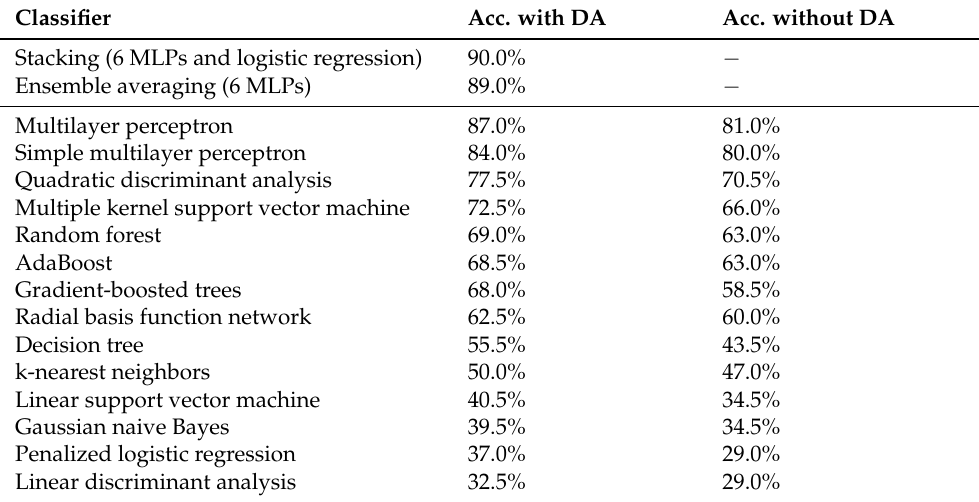
Table 3. Test accuracies of different classifiers with dimensionality reduction by feature selection (FS), with and without data augmentation